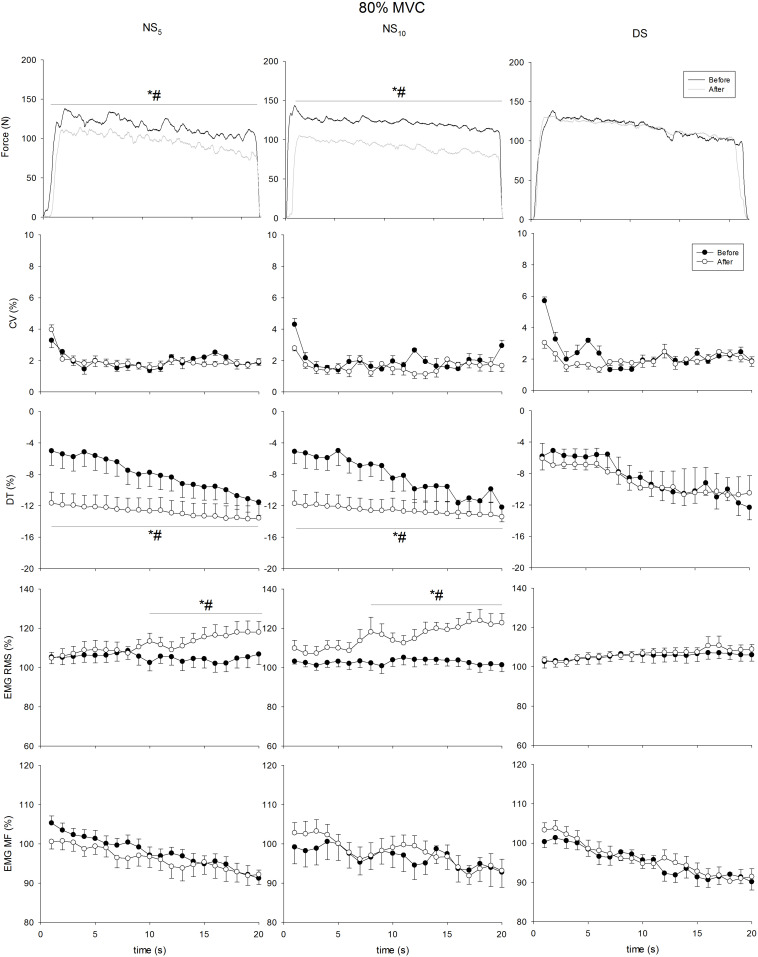
Coefficient of variation (CV), distance to target (DT), surface electromyogram root mean square (sEMG RMS), and mean frequency (sEMG MF) at 80% of maximum voluntary contraction (MVC) force maintained for 20 s at the beginning (pre, solid circle) and at the end (post, blank circle) of the shift cycle in the three groups. NS5, 5-day night shift; NS10, 10-day night shift; DS, day/swing shift. *p < 0.05 post vs. pre; #p < 0.05 NS5 or NS10 vs. DS.